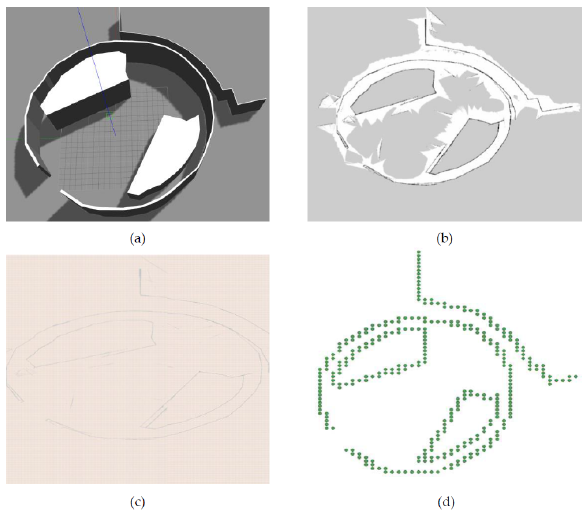
Figure 1. Pointcloud building: a) blender model of the environment; b) model in the Gazebo simulation tool; c) scanning the indoor environment via robot’s LiDAR sensors that Turtlebot3 robot is equipped with. The fourth step, in 1.(d), is to reason on the LiDAR sensed values and extract a point cloud After the pointcloud is acquired, points are first clustered into lines, which are later clustered into polylines or polygons. Clus- tering points into objects is achieved via buffering, where each point’s boundaries are extended until they overlap with bound- aries of another point or reach a maximum threshold. After points are structured into groups according to their nearest neighbors, a second level of clustering is applied that enables us to separate points that belong to different polygons